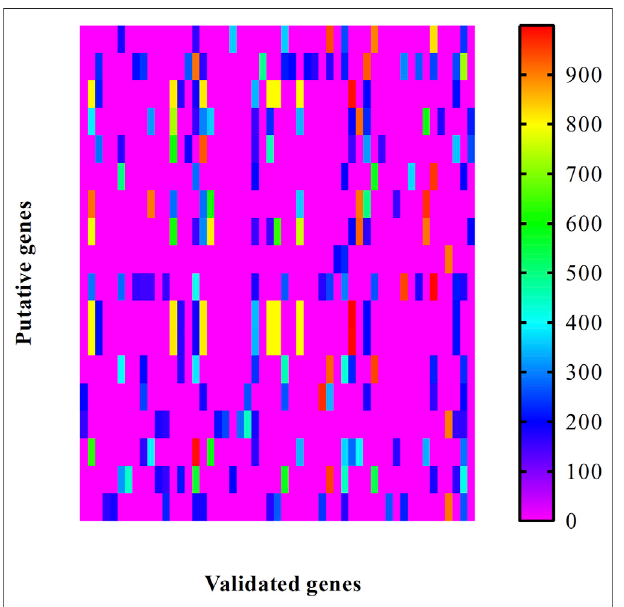
FIGURE 2 | Heat map to illustrate the associations between putative genes and validated ones associated with congenital deafness. Row represents putative genes and column indicates validated genes.